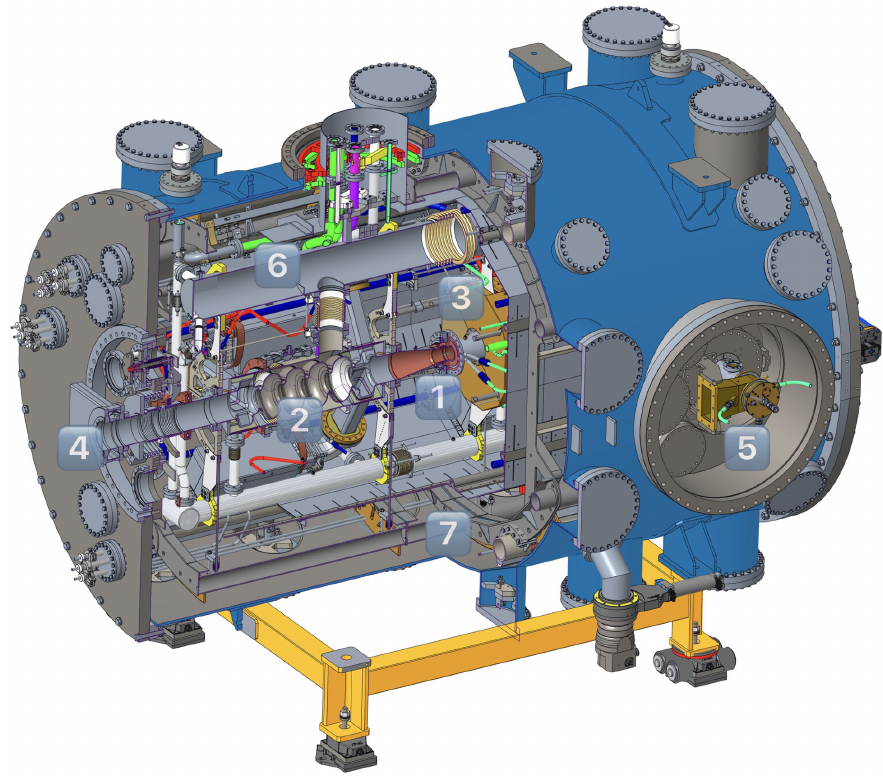
FIG. 1. The VSR DEMO module construction [4] has recently been built. The CSB ((1) brown, half cut) is located in the middle of two 1.5-GHz SRF cavities (upstream one (2) shown cut, downstream one hidden in its magnetic shield (3)). Further elements among others are the upstream beam pipe entry (4), the downstream fundamental power connection (5), the He gas return pipe (6), and the supporting space frame